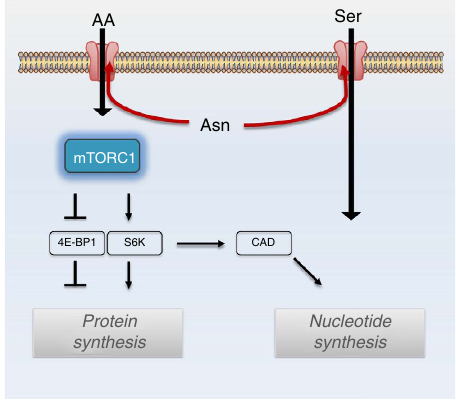
Figure 8 | Asparagine coordinates protein and nucleotide synthesis. Model illustrating asparagine contribution to protein synthesis and nucleotide synthesis. Intracellular asparagine exchanges with extracellular amino acids (AA), including serine (Ser), to coordinate protein